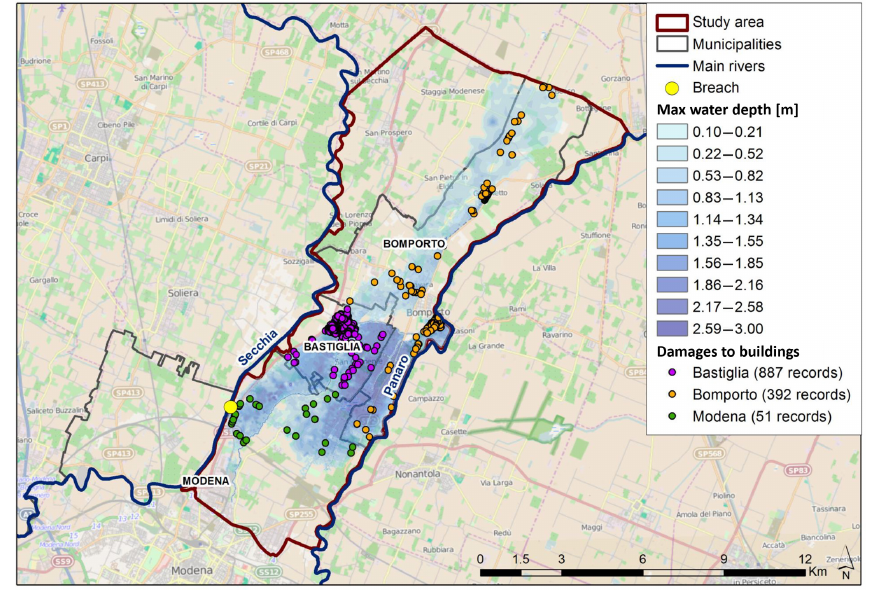
Figure 2. Maximum water depths simulated by the 2-D model; geolocated building damages (colors reflect